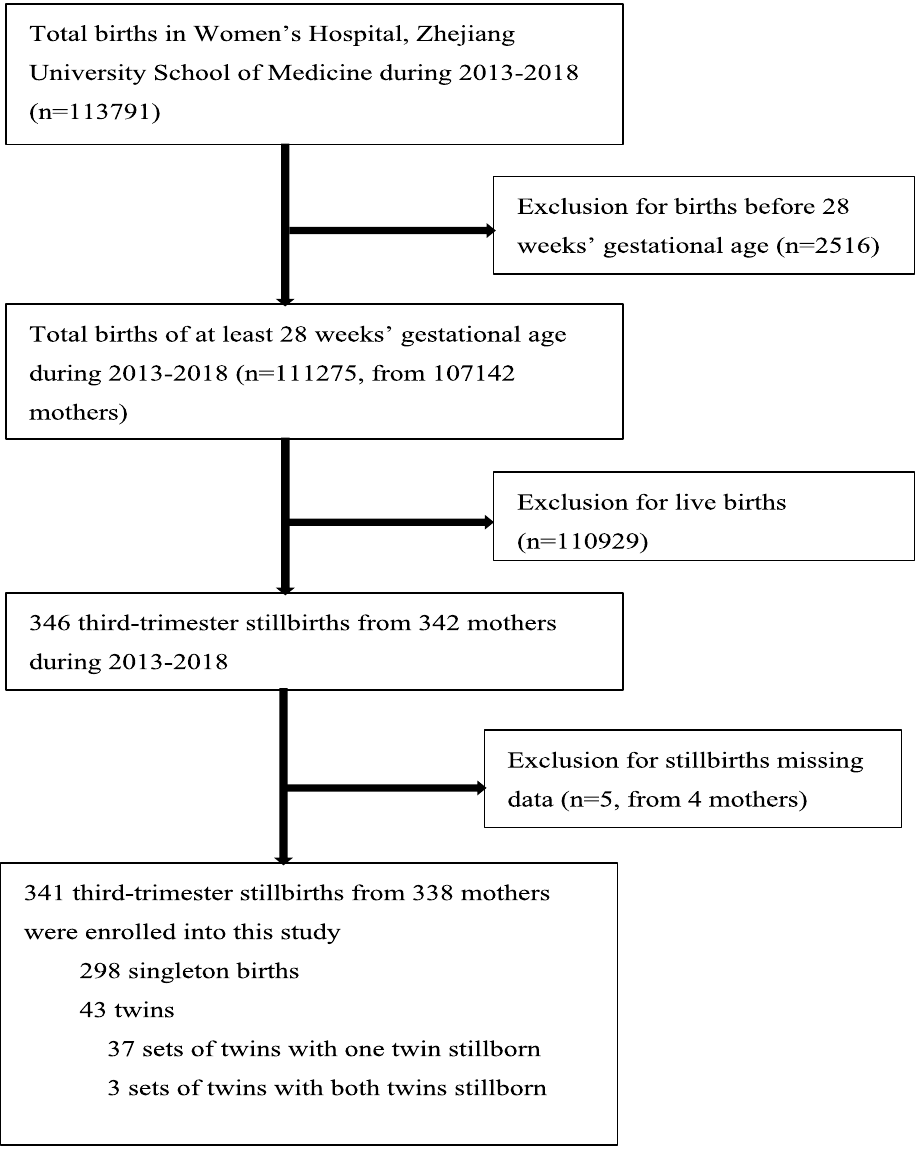
Figure 1. Third-trimester stillbirths in Women’s Hospital, Zhejiang University School of Medicine between Jan 1, 2013 and Dec 31,